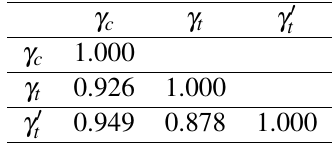
Table 2 Cross correlation matrix of domination parameters.